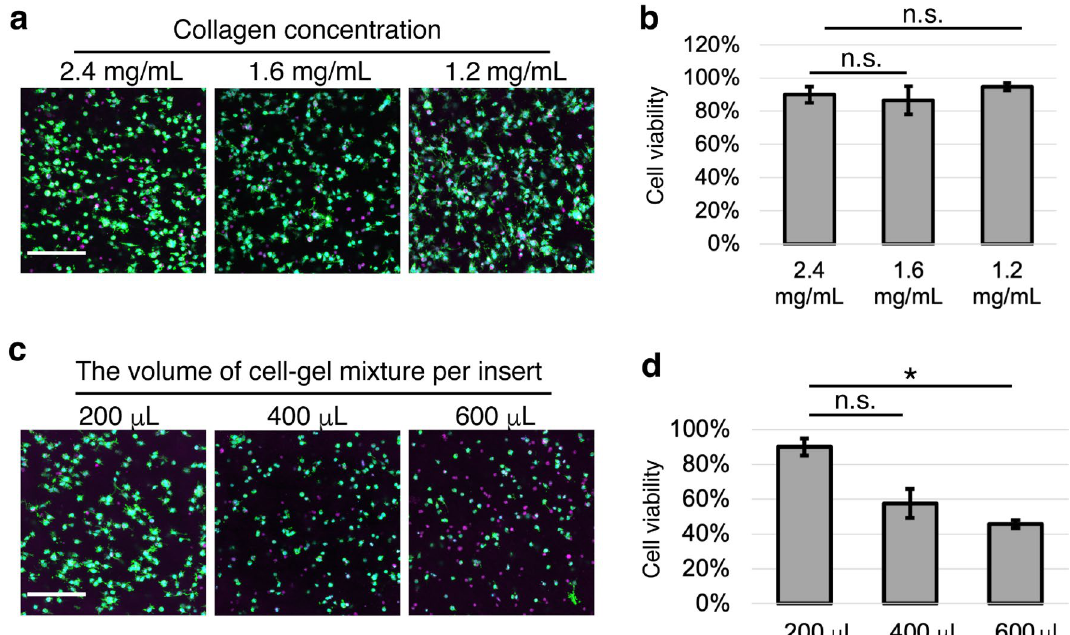
Figure 4. Gel volume, but not collagen concentration, affected cell viability. ( a, b ) Fluorescent images ( a ) and analysis ( b ) of cells embedded in 200 μL of gel with different concentrations of collagen based on the live/ dead cell assay. ( c,d ) Fluorescent images ( c ) and analysis ( d ) of cells embedded in 2.4 mg/mL collagen gels with different volumes based on the live/dead cell assay. Cells were cultured for 3 days with PCC-WLD with a syringe. The center of the gel was observed. Cyan, Hoechst. Green, phalloidin. Magenta, RIF. Scale bar, 200 μm. n = 3 fields from 3 independent experiments. Mean ± S.E. n.s. no significance. *p < 0.05 by Student’s t -test with Bonferroni